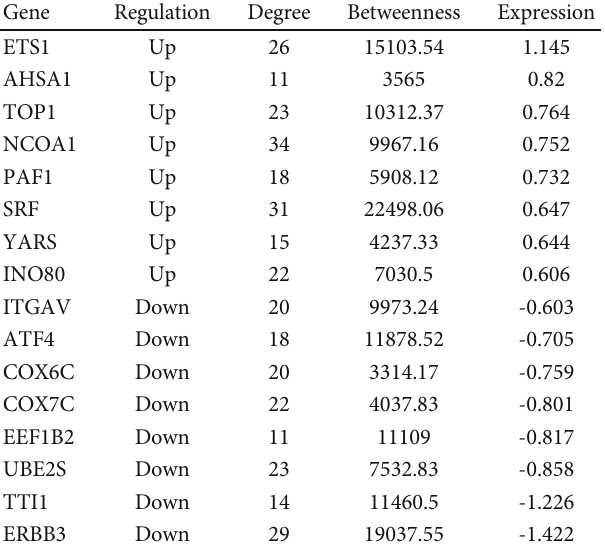
Figure 3: Protein-protein interaction network of the di ff erentially expressed genes. Red and orange nodes stand for hub genes. Table 3: Sixteen genes with degrees < 10 in the protein-protein Table 3. It turned out that 25 TFs regulate SRF, 18 TFs interaction network of the di ff erentially expressed